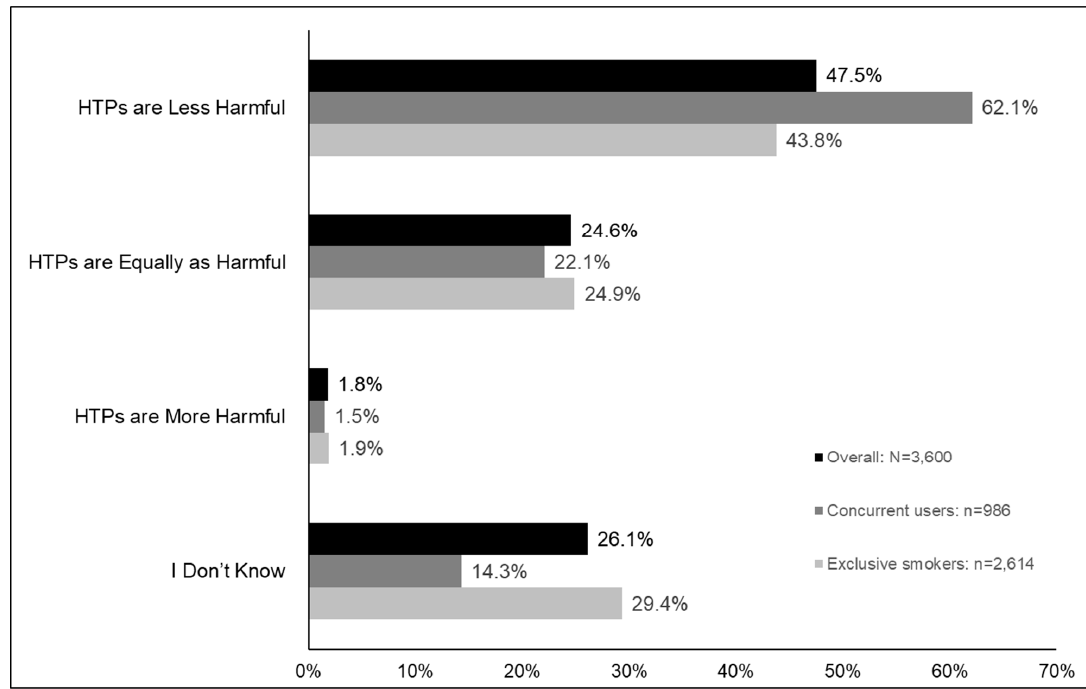
Figure 1. Relative perceptions of harmfulness of HTPs compared to cigarettes among smokers in Japan in 2018.